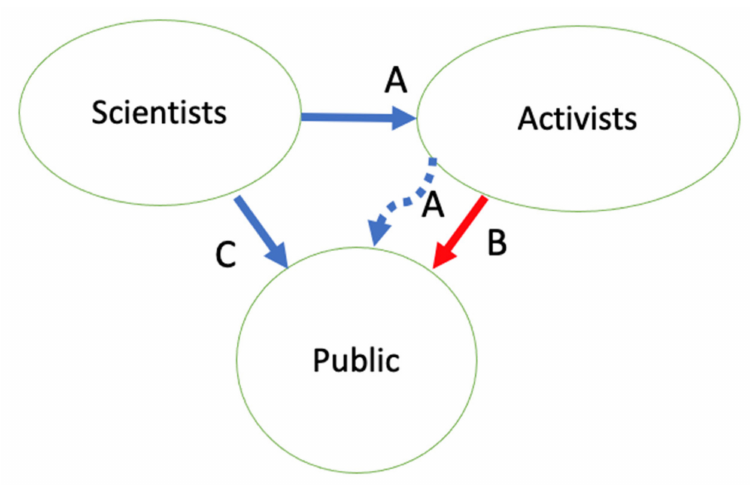
Figure 1. Animal-use information flow, as perceived by some research defenders. ( A ) Activists take information from science and scientists and mischaracterize it to pass on to the public. ( B ) Activists disseminate information with no basis. ( C ) Scientists bypass communication with activists to directly show and tell the public their version of laboratory animal